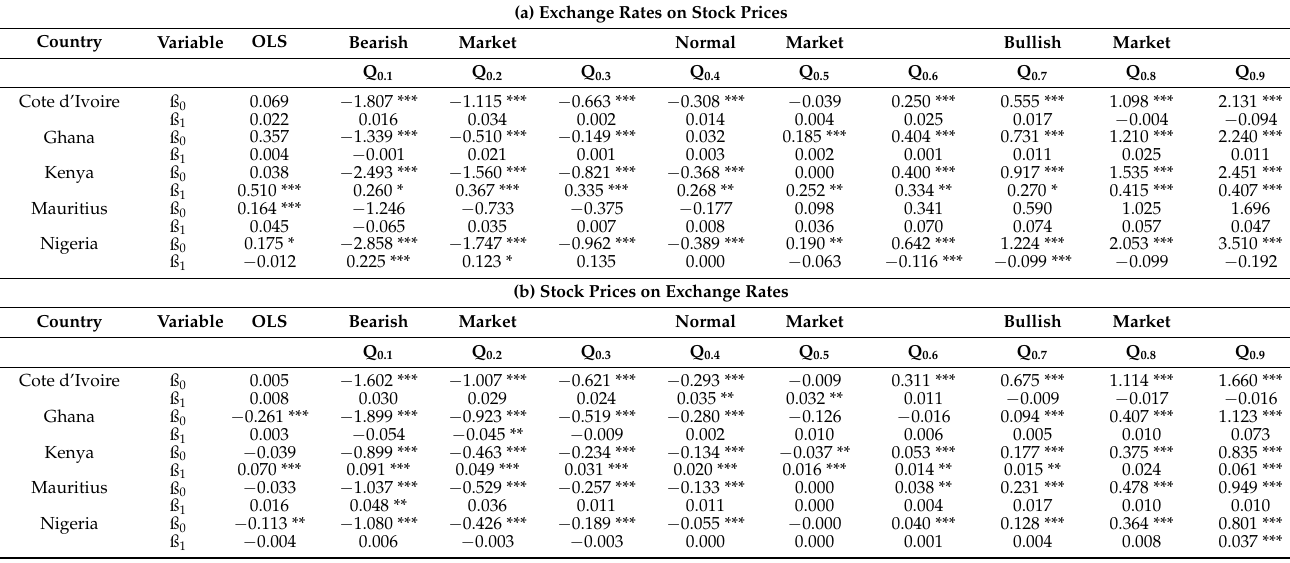
Table 12. Effects of ( a ) exchange rates on stock prices and ( b ) stock prices on exchange rates. (a) Exchange Rates on Stock Prices